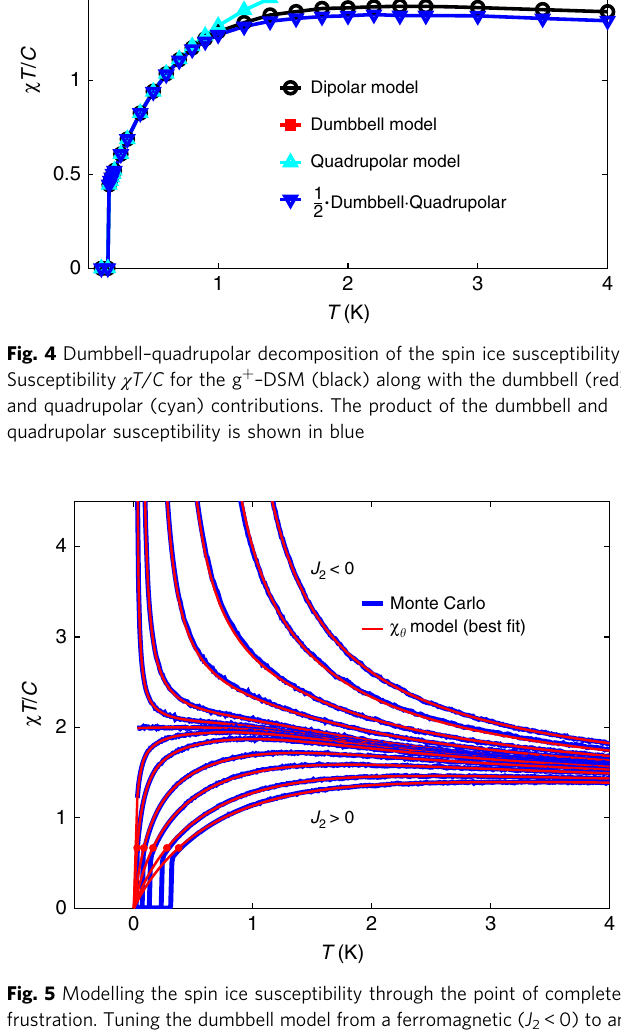
Fig. 5 Modelling the spin ice susceptibility through the point of complete frustration. Tuning the dumbbell model from a ferromagnetic ( J 2 < 0) to an antiferromagnetic ( J 2 > 0) ground state. The J 2 range extends from − 0.2 K for the uppermost curve to + 0.2 K for the lowest curve. Monte Carlo data (blue) lie below the corresponding optimal two-parameter fi t (red) to the phenomenological χ θ model (Eq. (10)). On the antiferromagnetic side, the (cid:10) (cid:10) (cid:5) 2 = 3, which lies very close to the solid red circles indicate χ θ T = C T ¼(cid:1) θ critical temperature in Monte Carlo, visible as vertical blue